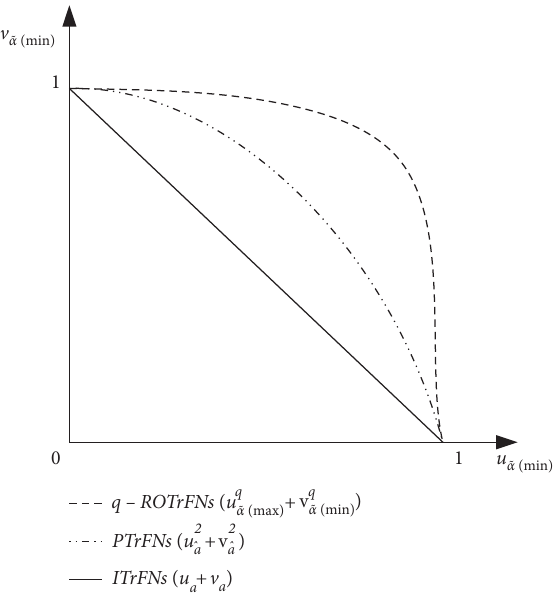
Figure 2: Information space with different values of q